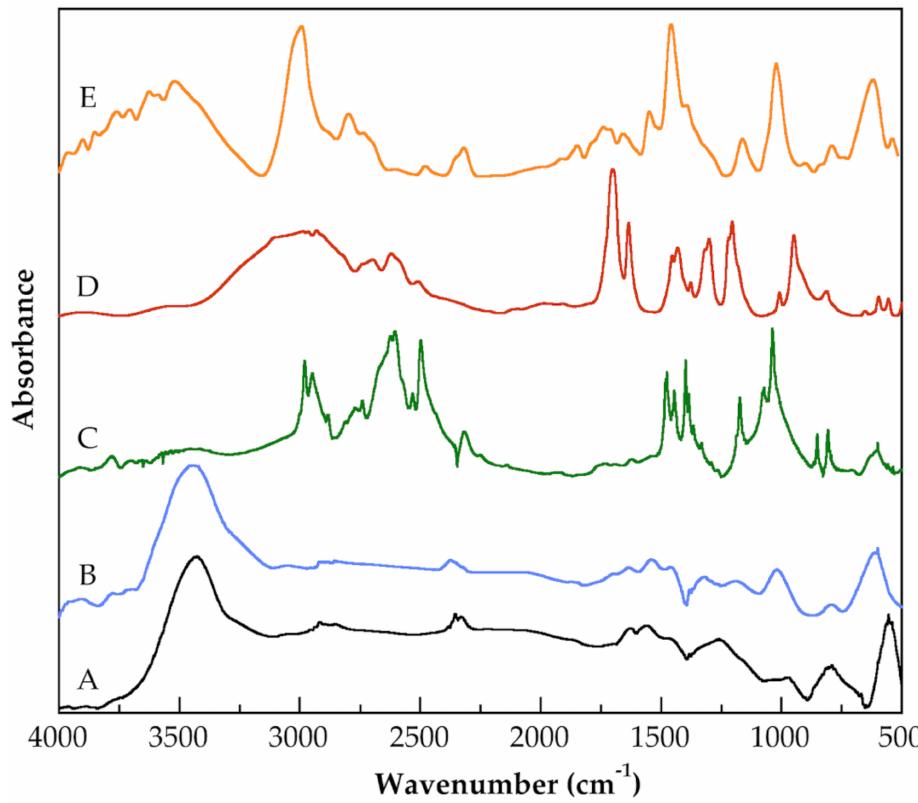
Figure 3. FT-IR spectra of CNTs p ( A ), CNTs o ( B ), CNTs o-OCl ( C ), pure MAA ( D ), and CNTs o-OCl-MAA ( E